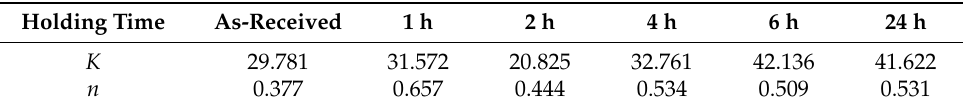
Table 5. The value of K and n of the foams held for 2 h.